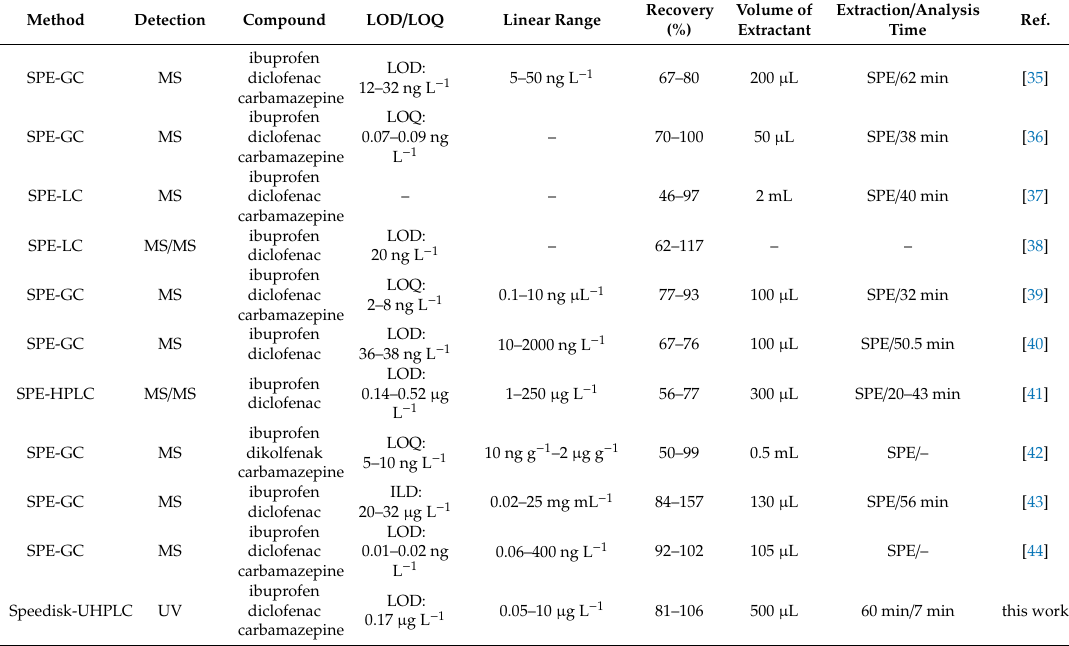
Table 4. Comparison of the developed Speedisk solid phase extraction method with other methods to extract drugs from water samples described in the